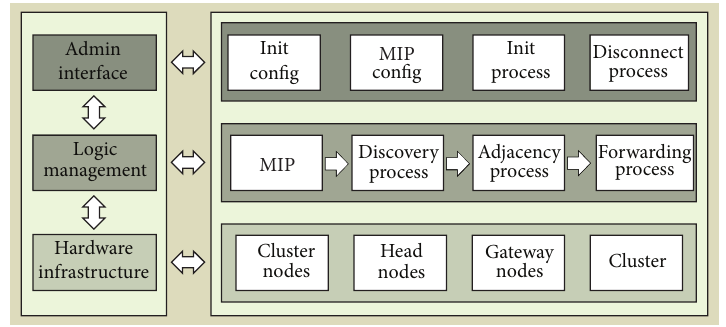
Figure 2: Multimedia ad hoc wireless network architecture